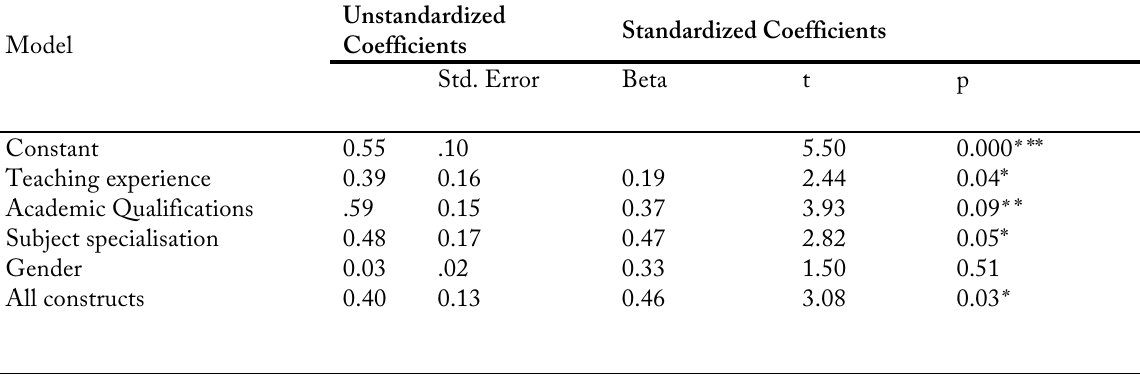
Table 3: The Parameter Estimates of Teachers’ Inputs on Students’ Academic Achievement in